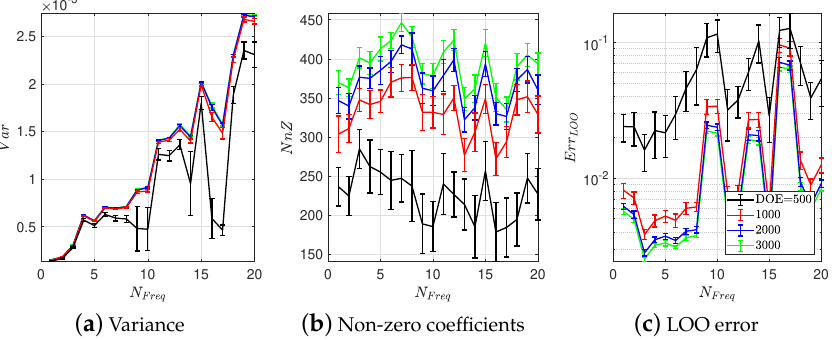
Figure 11. Dam-2; impact of DOE size on the PCE-based surrogate models for frequency response.